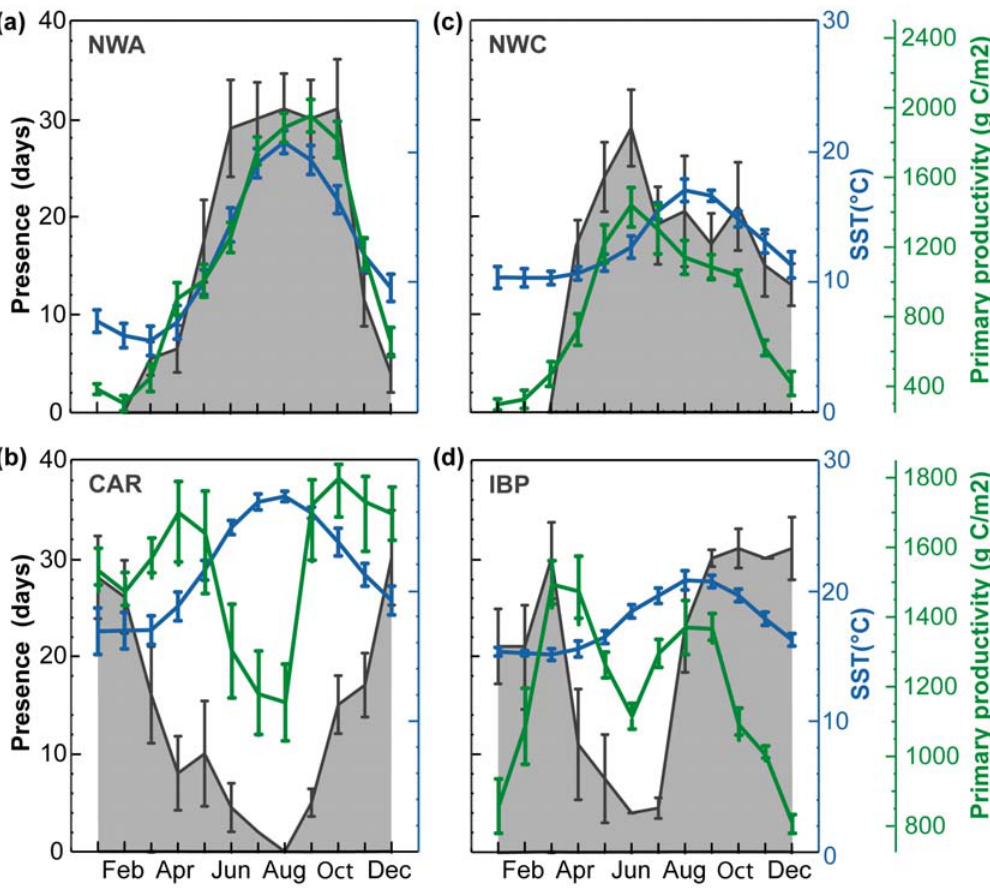
Figure 6. Mean ( 6 SD) monthly number of days that bluefin tuna were present (1996–2005) within high use areas (grey shaded) in relation to mean ( 6 SD) monthly level of primary productivity (green line) and sea surface temperature (blue line). (a) Nortwest Atlantic (n=32) (b) Nortwestern Corner (n=5) (c) Carolina (n=52) (d) Iberian Peninsula (n=4).